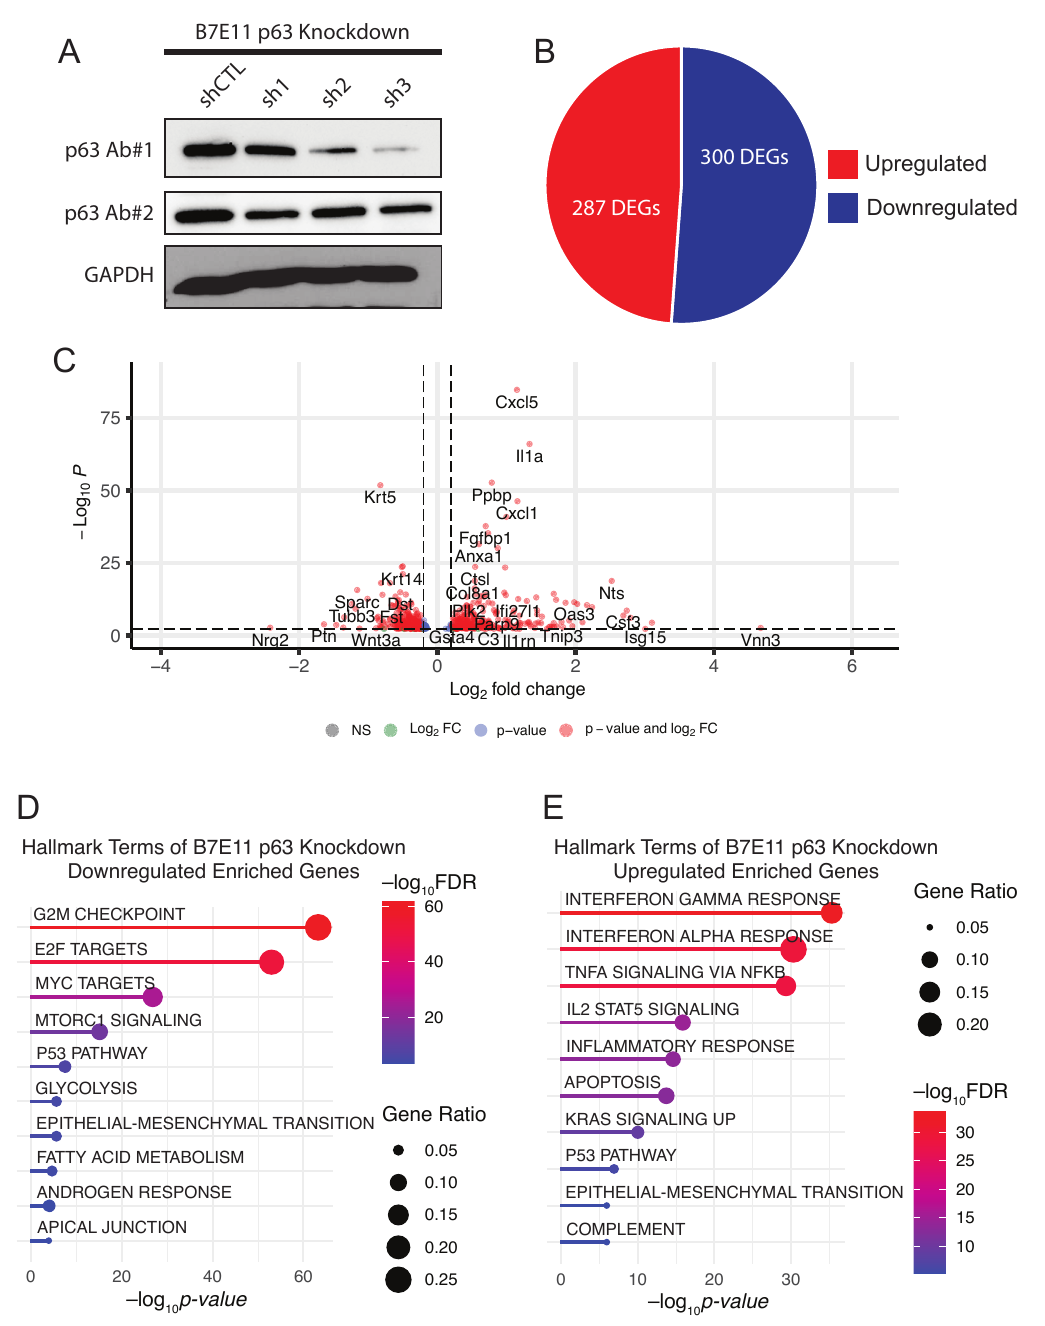
Figure 3. p63 knockdown in p63 high B7E11 cells. ( A ) Western blot analysis of p63 expression in B7E11 cells expressing either p63-targeting shRNAs or a nontargeting shRNA (shCTL). GAPDH was used as a loading control. A pie chart ( B ) and a volcano plot ( C ) of DEGs resulting from sh3 in B7E11 cells. Enriched hallmark terms in downregulated ( D ) and upregulated ( E ) DEGs in B7E11 cells with p63